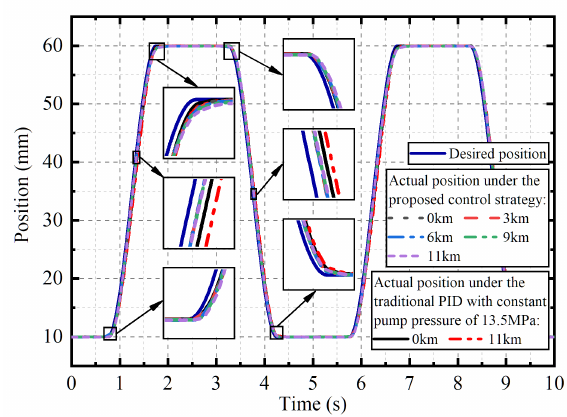
Figure 8. Tracking performance of multi-step